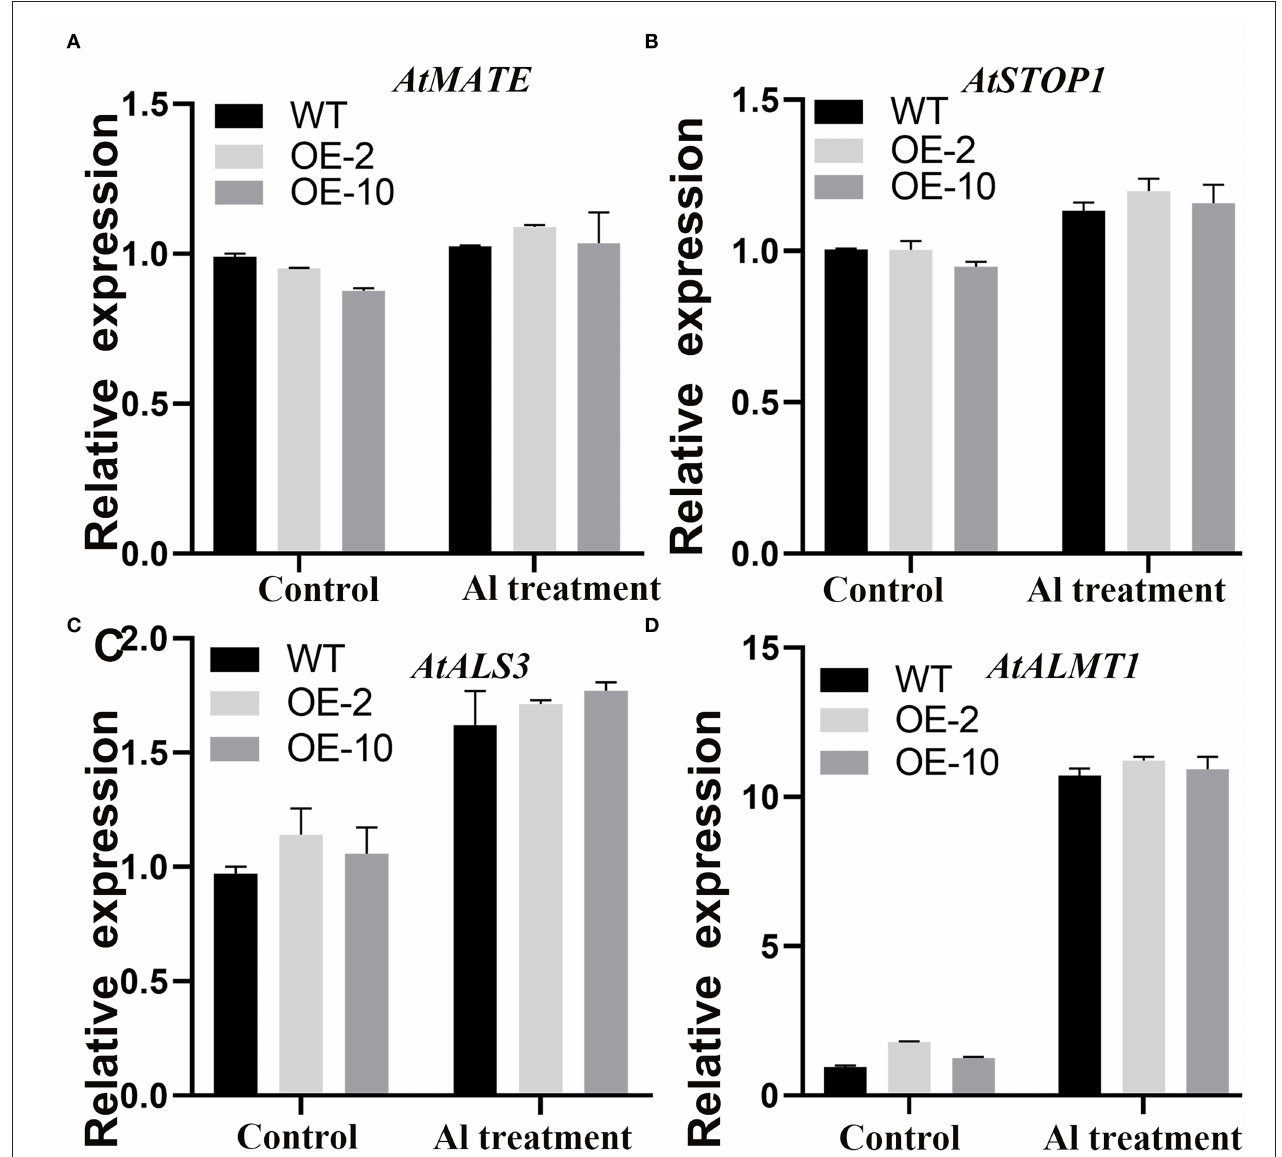
FIGURE 6 | (A–D) Expression patterns of genes responsive to Al stress. WT: wild-type Arabidopsis; OE-2, OE-10: GmWRKY21 overexpression transgenic lines. WT and transgenic Arabidopsis were grown on 0 or 100 µ M AlCl 3 (pH 4.3) 1/2MS medium for about 10 days. All data are presented as means ± SEM ( n = 3). Significant differences according to the one-way analysis of variance are